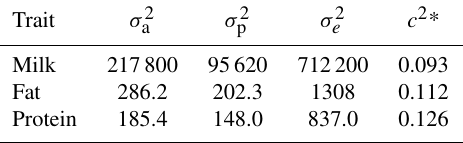
Table 2. Estimates of additive genetic variances ( σ 2 a ), permanent variances ( σ 2 p ), residual variances σ 2 e , and permanent environmen- tal variance proportion ( c 2 ) for milk, fat, and protein yields with